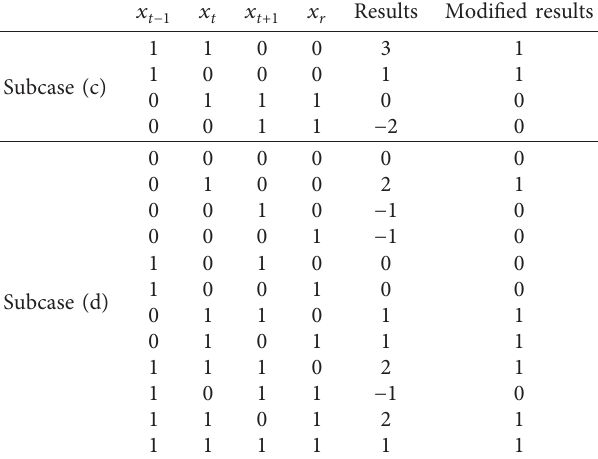
Table 7: Results of the binary junior gaining and sharing stage of Case 2 with k f � 1.